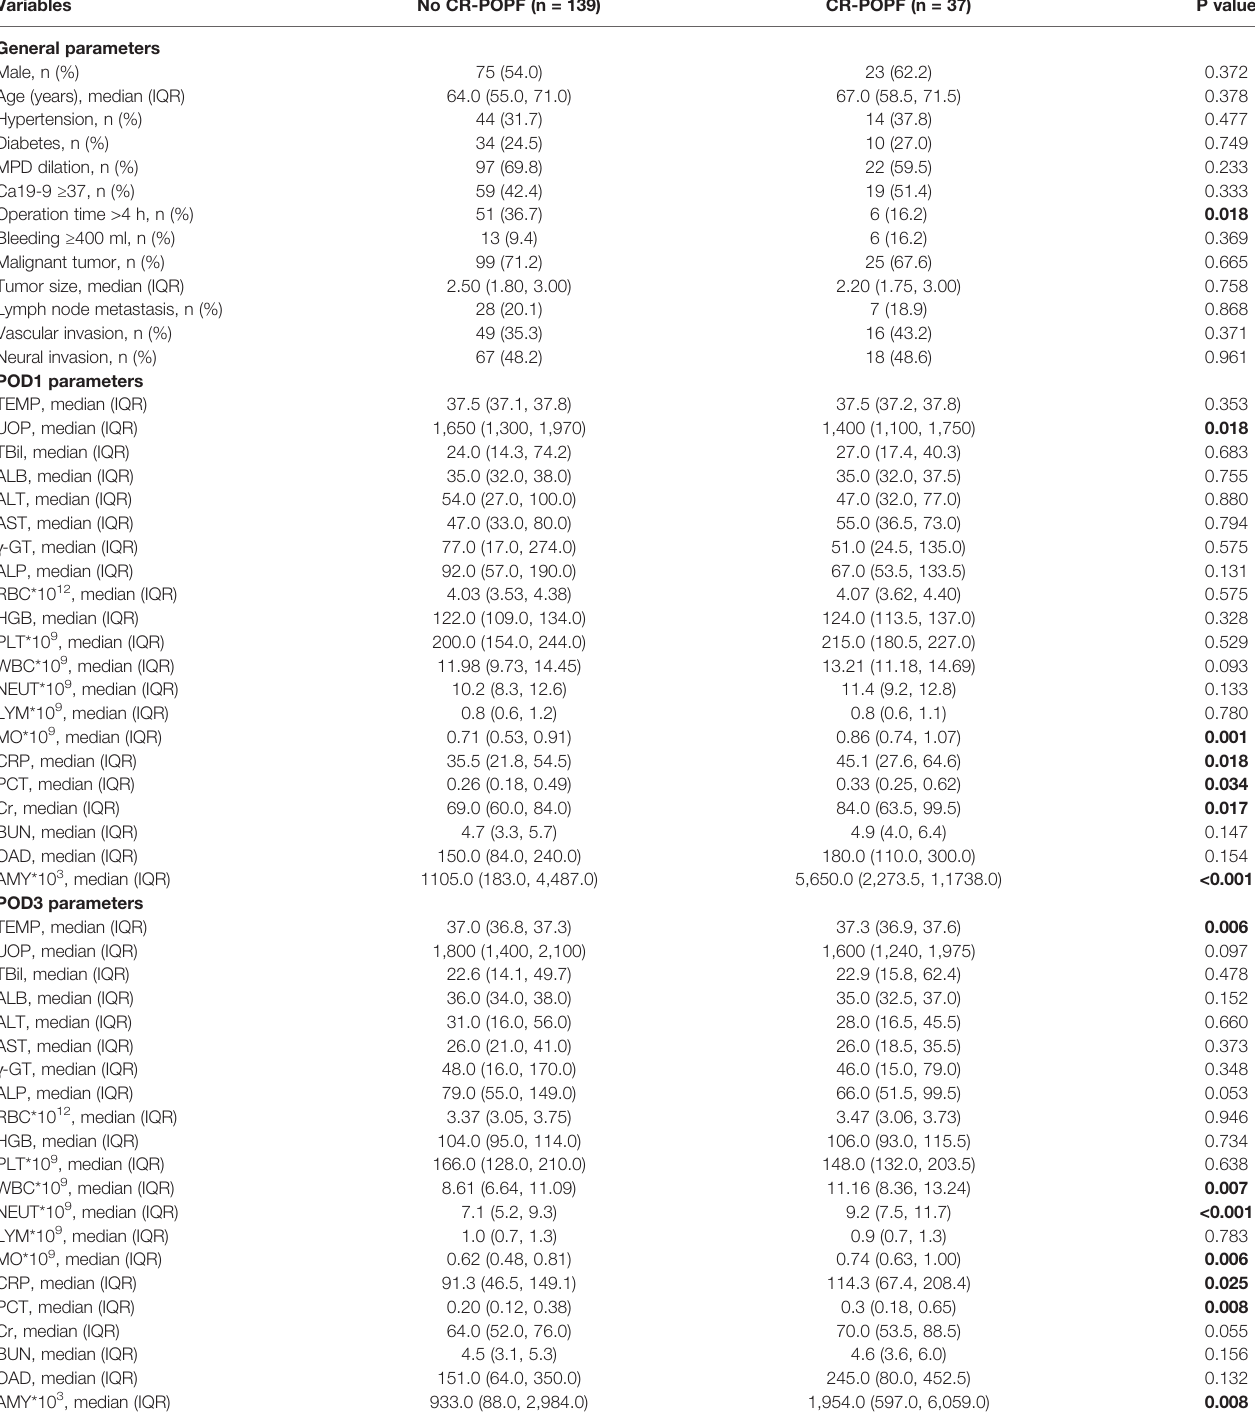
TABLE 1 | Demographic and clinical characteristics of patients with CR-POPF following PD.